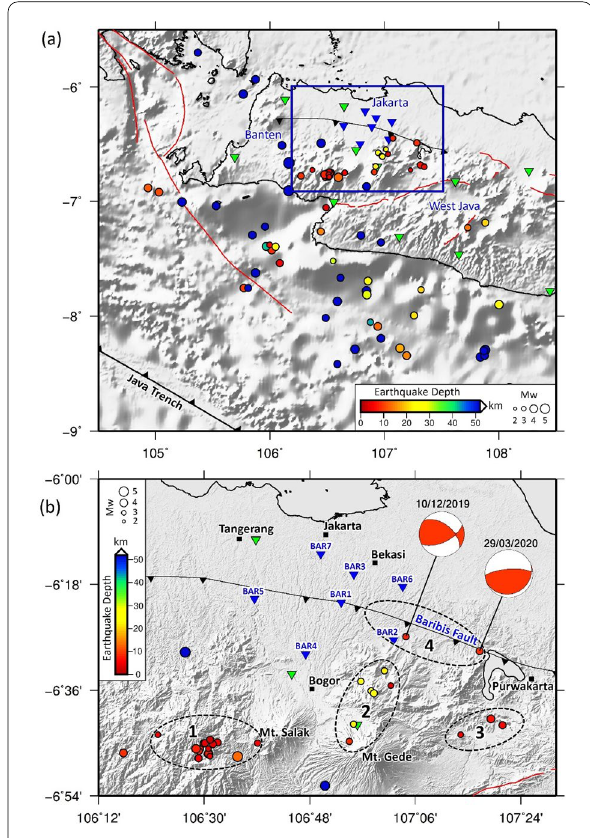
Fig. 7 a Map of the earthquakes which were recorded and located using borehole and BMKG seismometers, except Region 2 in which events were not recorded by BMKG stations and located using borehole seismometers only. Blue rectangle shows the location of the study area. b Distribution of the inland events divided into four regions. Colored dots depict the focal depth of the hypocenters. Blue and green inverted triangles are the borehole and BMKG seismic stations, respectively, used in this study. The black line represents the Baribis Fault according to Simandjuntak and Barber (1996). Focal mechanism solutions of the December 10, 2019 (Mw 3.0) and March 29, 2020 (Mw 3.2) events with a depth of 8.5 and 9.2 km, respectively, along the Baribis Fault are also